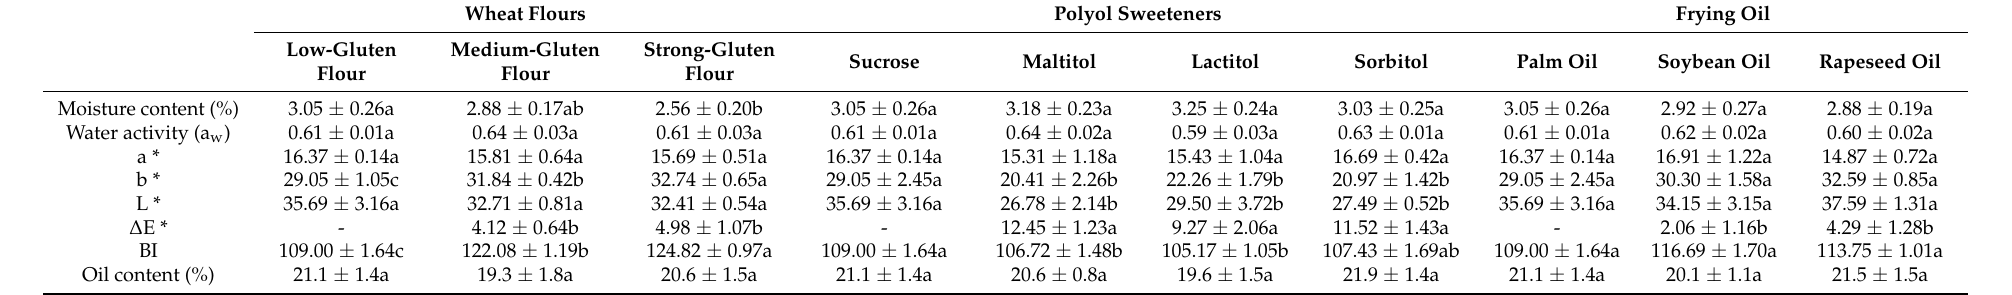
Table 1. Effect of main ingredients (wheat flours, polyol sweeteners, and frying oil) on moisture content, water activity (a w ), color parameters, and oil content of fried dough twist (FDT).